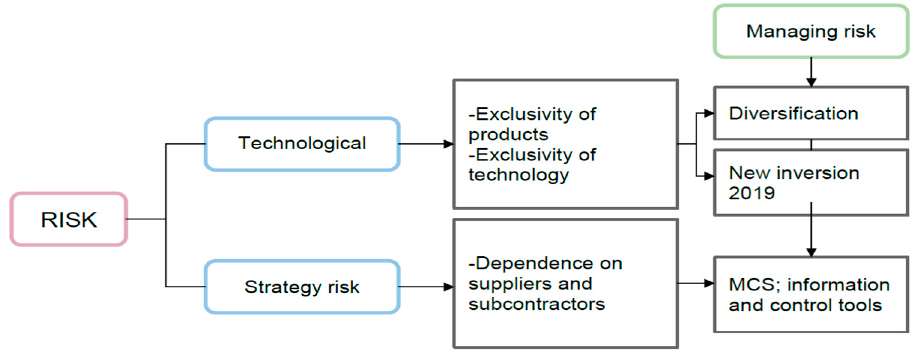
Figure 2. Management of risks for the Contractor. Source: Authors.